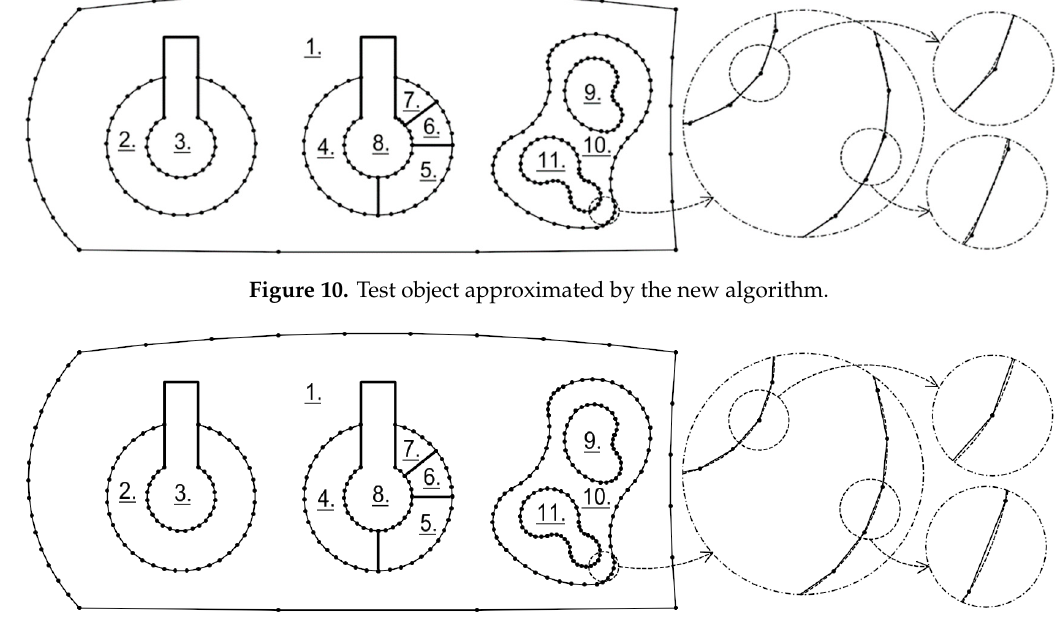
Figure 11. Test object approximated by the chord algorithm. Table 2. Area summary for two methods ( ∆ Area—area difference for the method of chords).